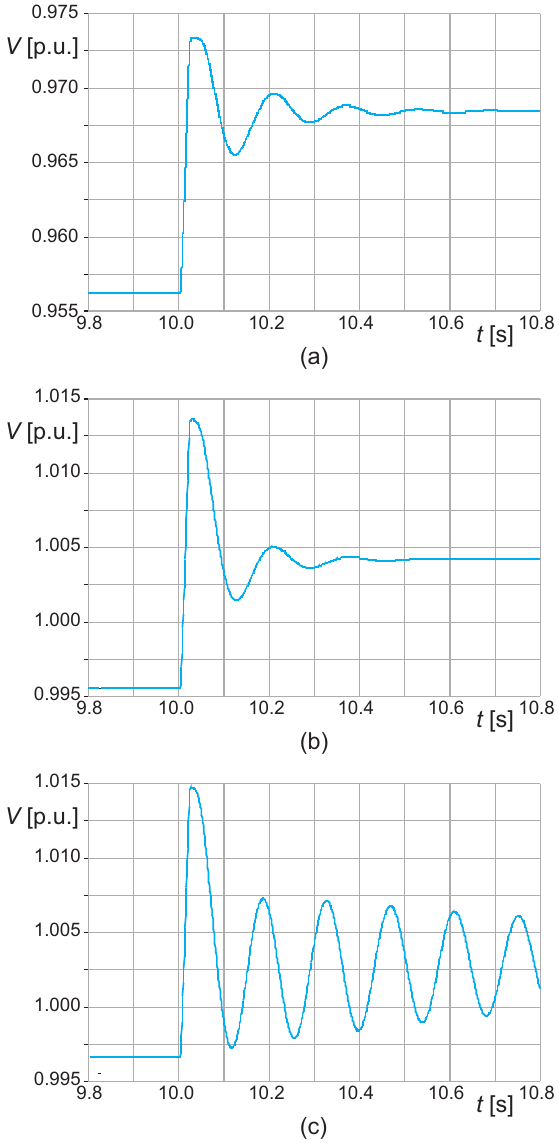
Figure 6. Time evolution of the voltage at Node #6 subsequent to the loss of load at Node #9 at time instant 10 s: ( a ) with the only PV System #1 connected to the network and SISO design k c 1 = 166.6; see Table 2, ( b ) with all six PV systems connected to the network and the chosen values for k ci ; see Table 2, ( c ) with all six PV systems connected to the network and doubled values for k ci with respect to ( b